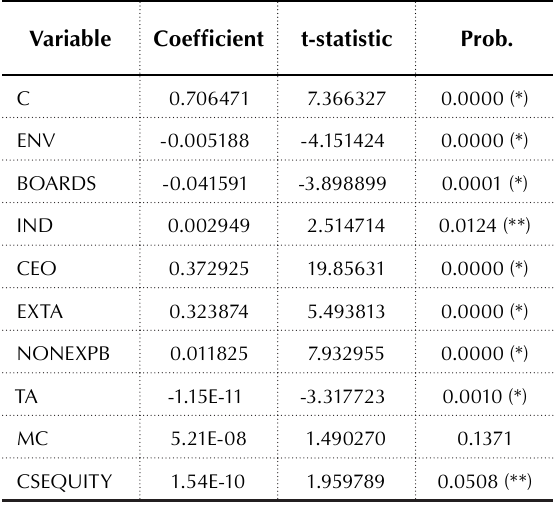
Table 2. Results (ROA as the dependent variable) Variable Coefficient t-statistic